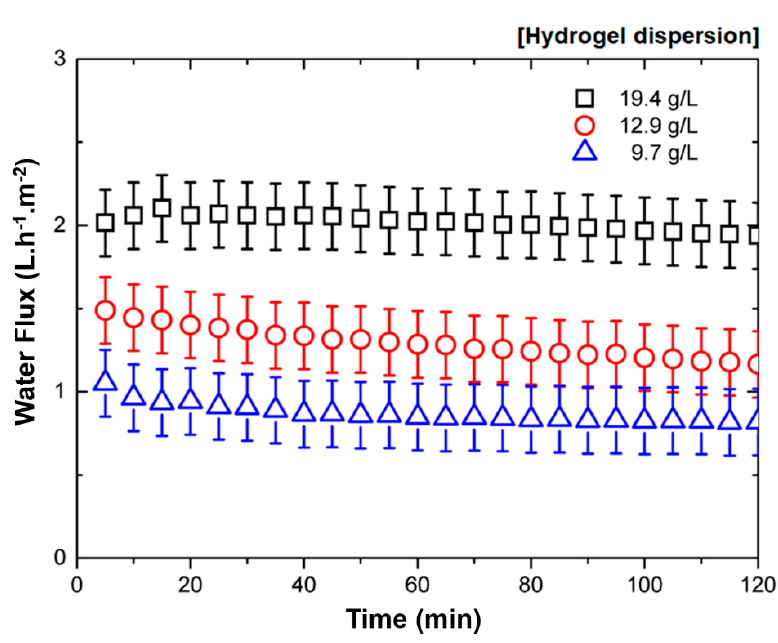
Figure 7. Generated water flux at various hydrogel concentrations.